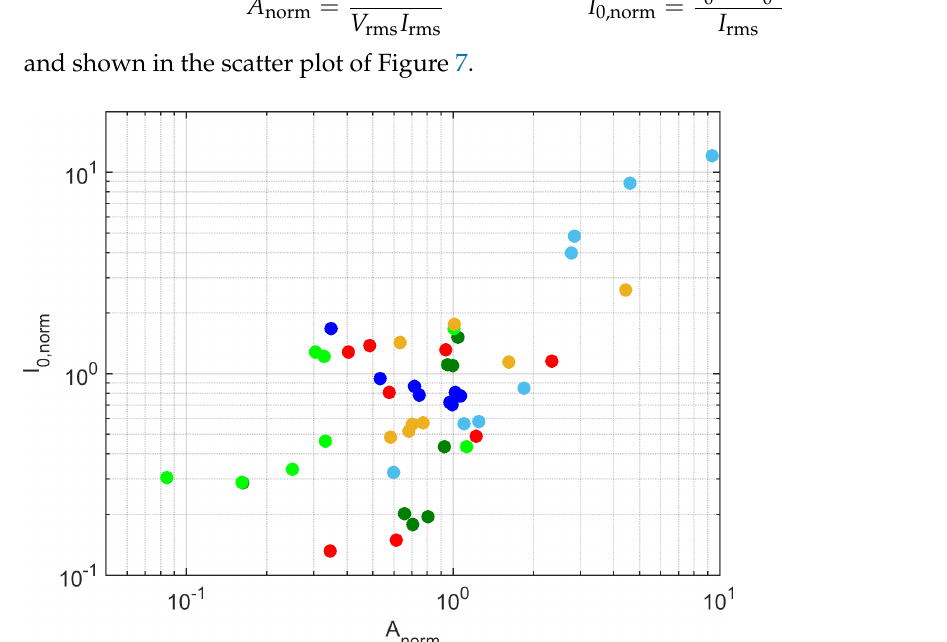
Figure 7. Scatter plot of normalized A and I 0 . The traction conditions are indicated by dark green, blue, and red for CH, D, and F, respectively; similarly, braking conditions have corresponding lighter